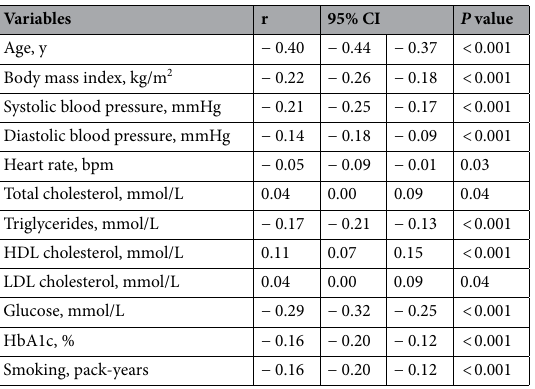
Table 2. Univariate analysis of the relation between FMD and variables in never smokers and current smokers of men. HDL, indicates high-density lipoprotein; LDL, low-density lipoprotein; FMD, flow-mediated vasodilation; 95% CI 95% confidence